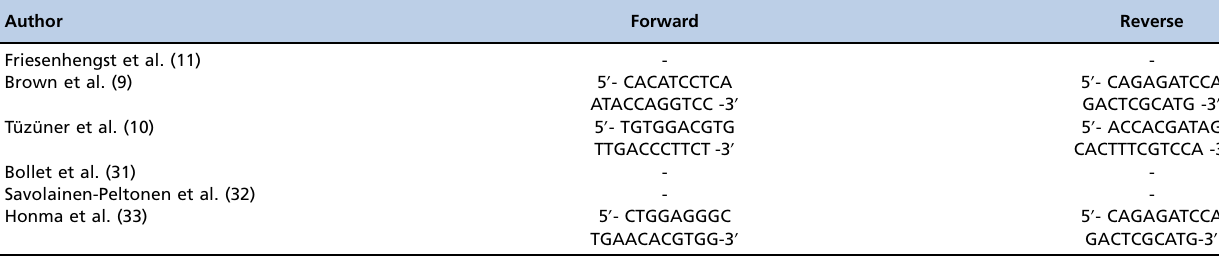
Table 2 - Primers CYP19A1 used in the qRT-PCR analysis from previous